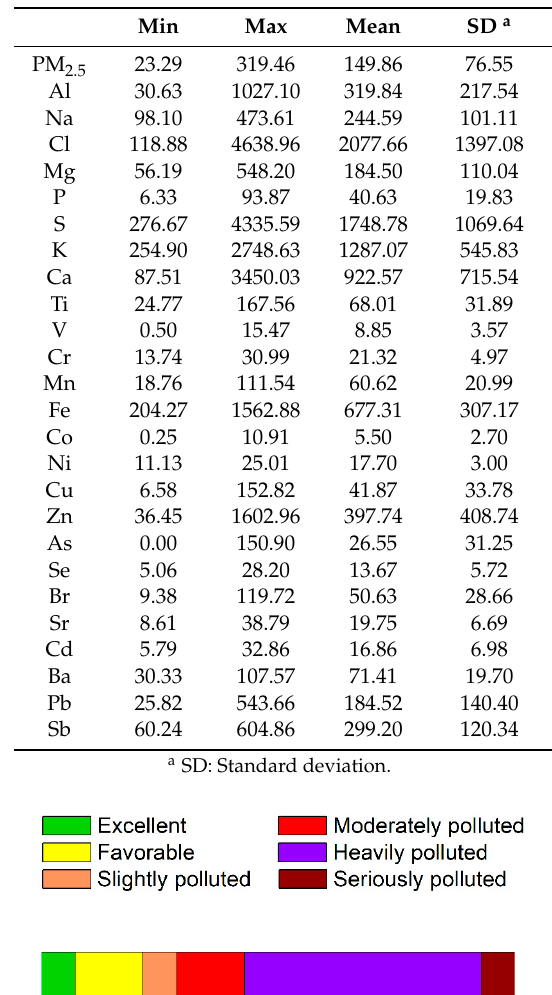
Table 1. Concentrations of PM 2.5 ( μ g m − 3 ) and trace elements (ng m − 3 ) during the sampling period. Min Max Mean SD a PM 2.5 23.29 319.46 30.63 Na 98.10 Cl